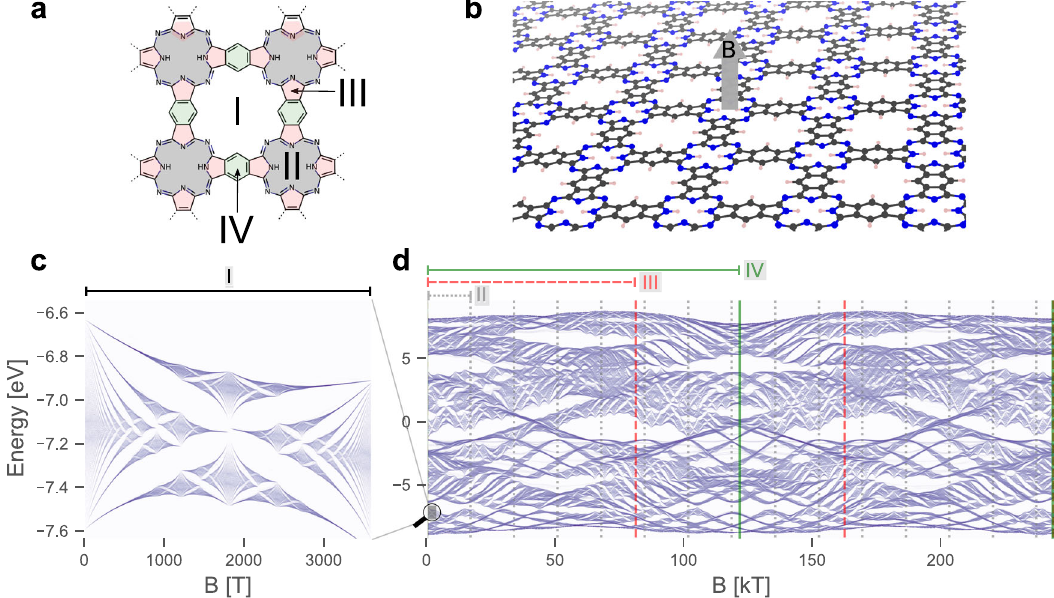
Fig. 3 Different periodicities in the butter fl y spectrum shown in the example of Phthalocyanine-COF. a Structure of the Phthalocyanine- COF including annotations for the largest to the smallest plaquettes (I – IV). b Extended 2D structure of Phthalocyanine-COF including an indicated applied magnetic fi eld. c HB from 0 to 3600 T. d Butter fl y spectrum from 0 to 245 kT. The solid green lines indicate the periodicity generated by plaquette IV (121.6 kT), the dashed red line by plaquette III (81.18 kT), and the dotted gray line by plaquette II (16.92 kT). The intensity of the DOS in the butter fl y spectra is depicted in a logarithmic scale although the colorbar was omitted for